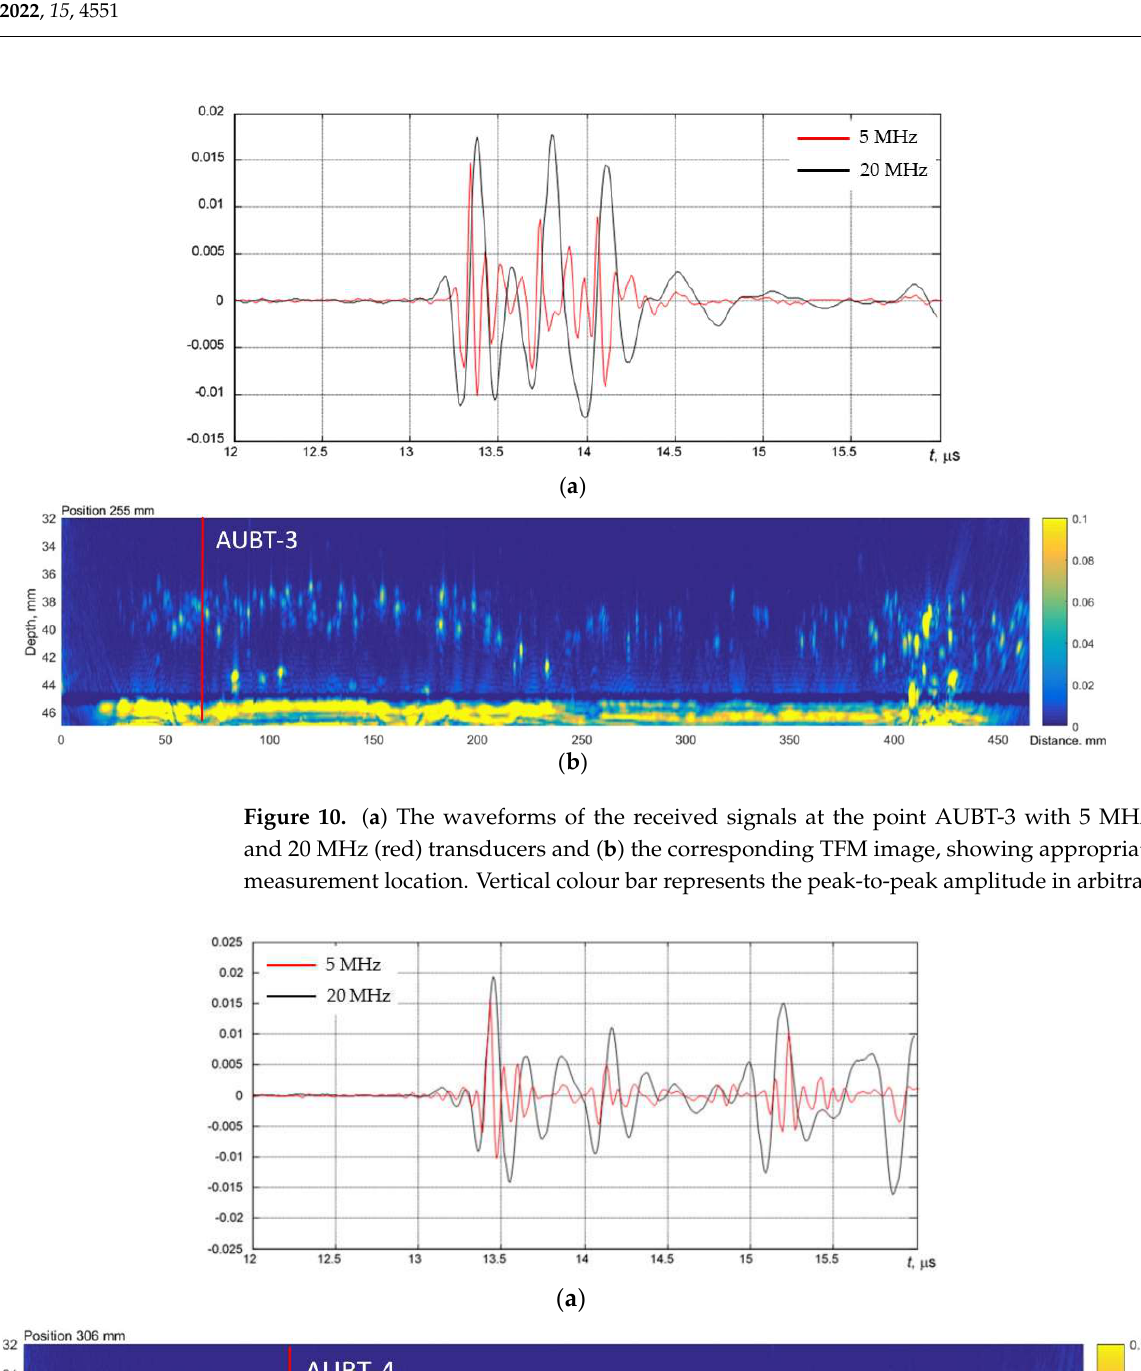
Figure 9. The waveforms of the received signals at the point AUBT-2 with 5 MHz (black) and 20 MHz (red) transducers.